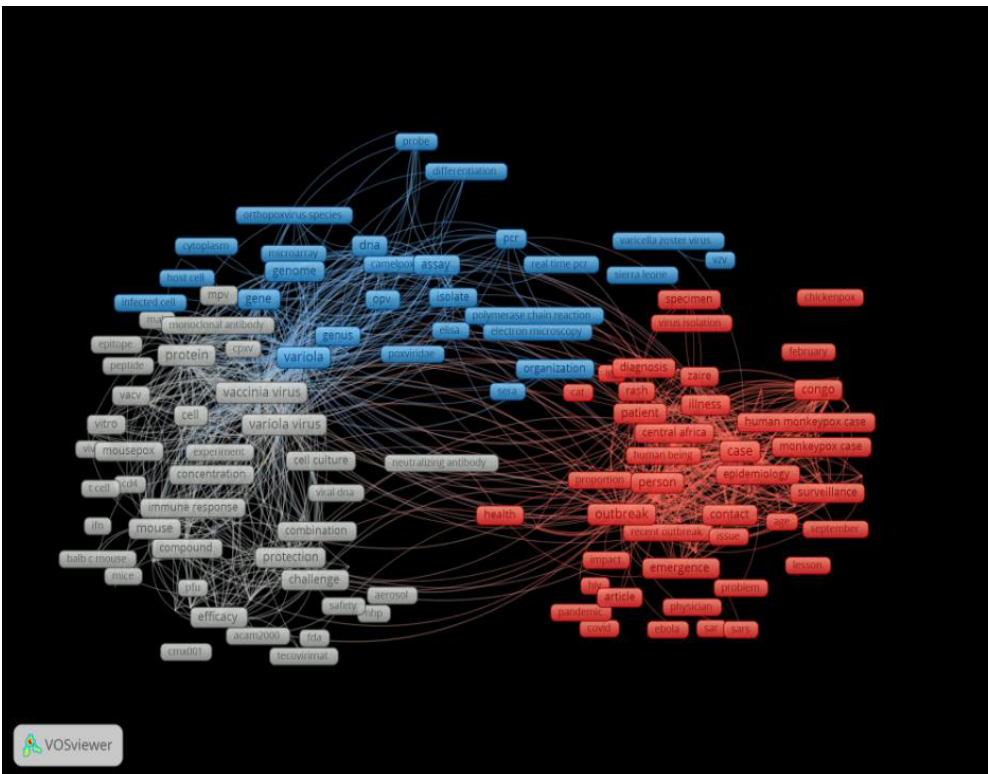
Figure 5a . Co-occurrence network of author